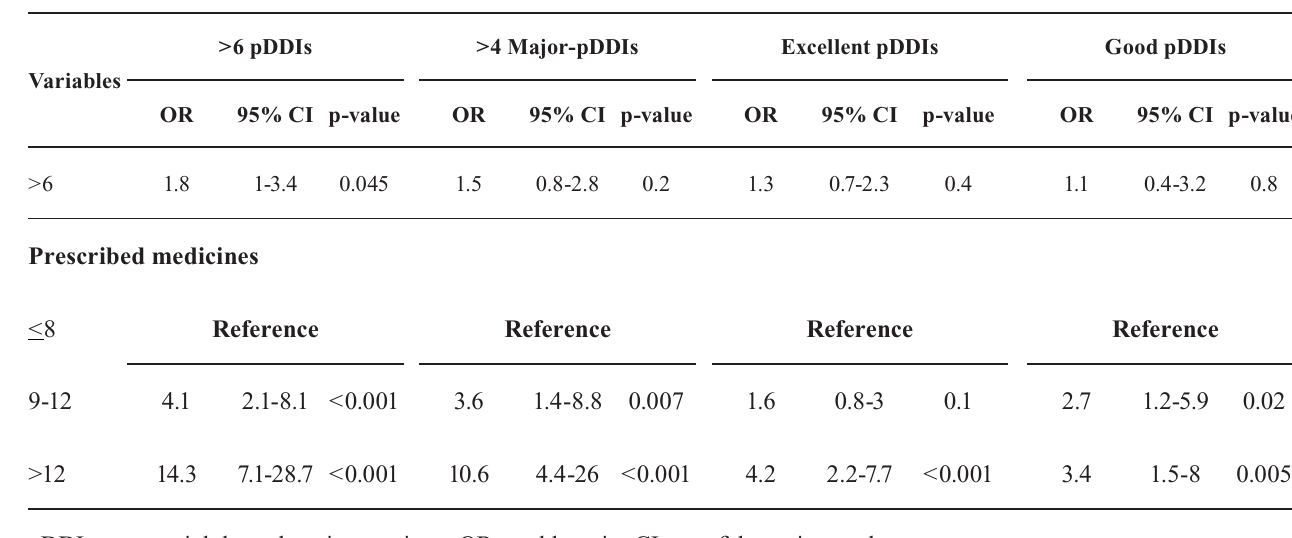
TABLE III - Univariate logistic regression analysis based on exposure to >6 pDDIs, >4 Major-pDDIs and documentation levels